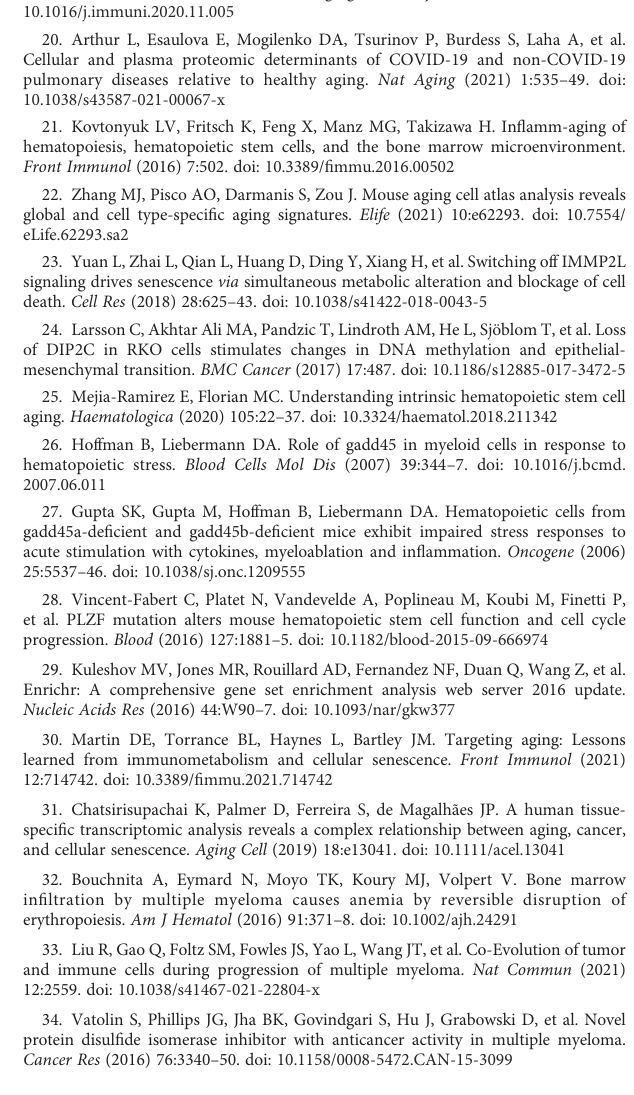
SUPPLEMENTARY TABLE 7 Multiple myeloma malignant plasma cell